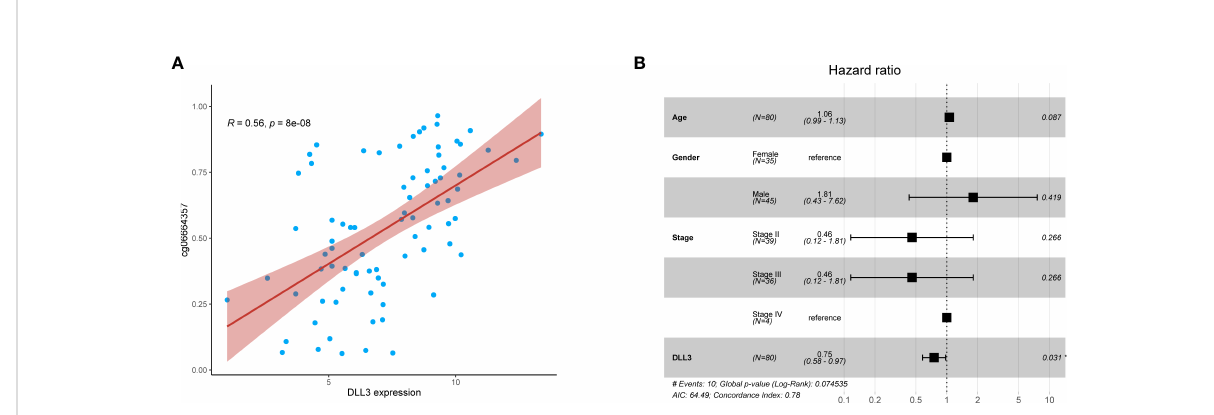
FIGURE 2 DLL3 expression was positively correlated with its DNA methylation level and served as an independent protective factor for UM patients. (A) The relationship between DLL3 expression and its methylation CpG cg06664357. (B) Multivariate Cox regression analysis indicated that DLL3 played a protective role in the prognosis of UM patients. * P <